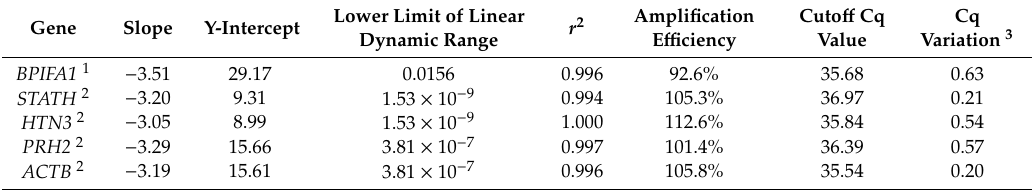
Table 2. Summary of the performance of the developed reverse-transcription quantitative polymerase chain reaction (RT-qPCR)